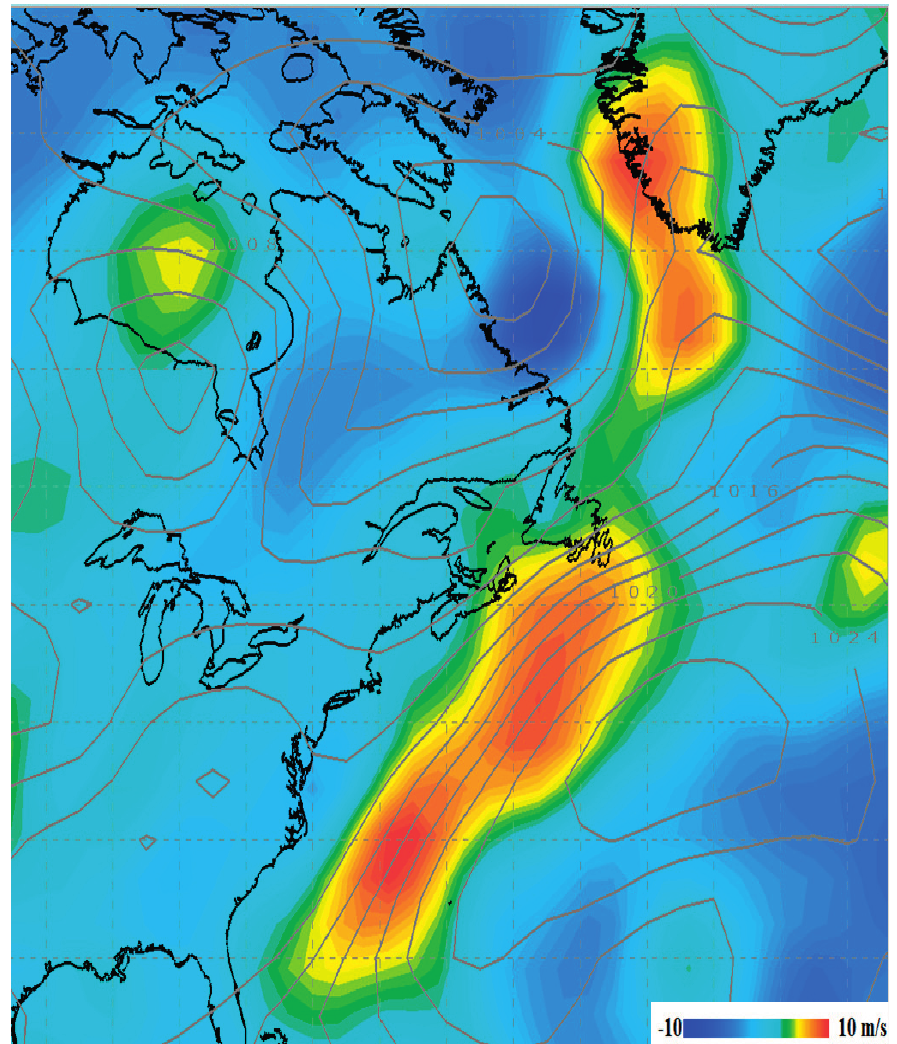
Figure 2. A daily composite from the NCEP Reanalysis of mean sea level pressure (grey contours) and surface wind speed (color contours) during the initial observation of the plume on 20